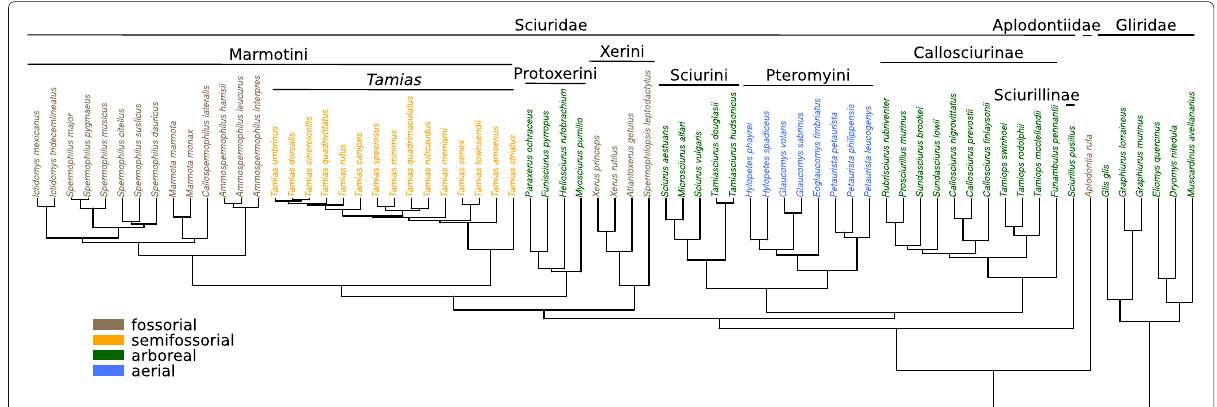
Fig. 1 Phylogenetic tree of the sciuromorph species analyzed in this study. Colors indicate the lifestyle